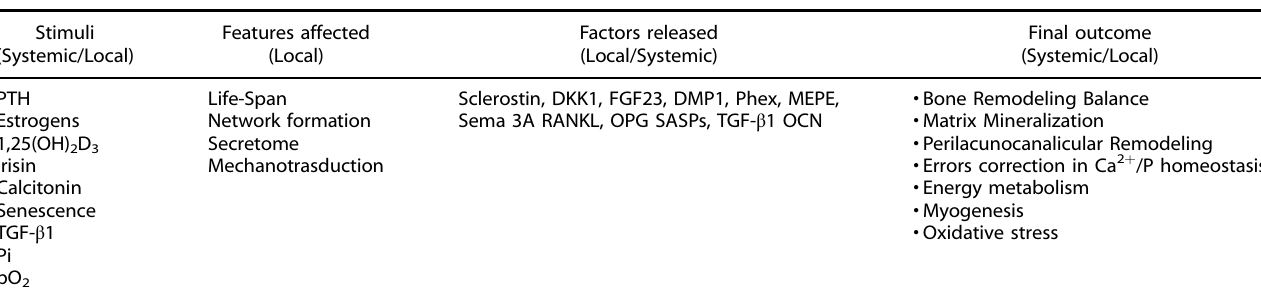
Table 1. Systemic and local factors in fl uencing osteocyte function Stimuli Features affected (Systemic/Local)